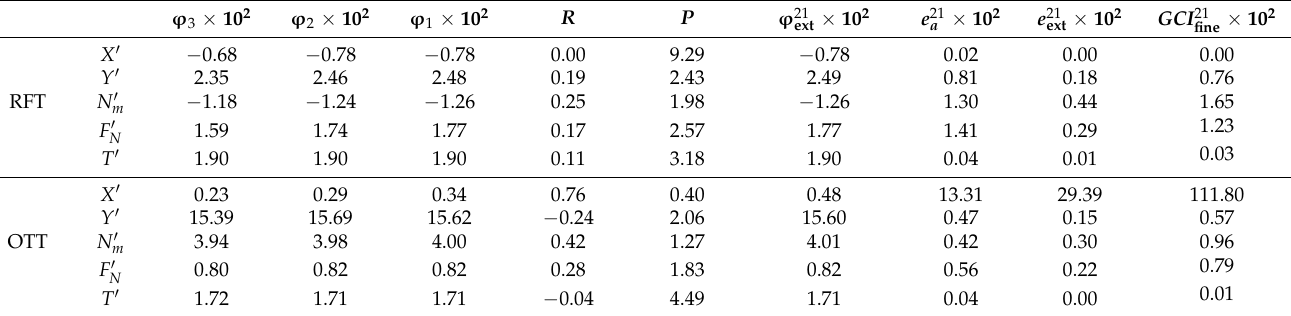
Table 5. The discretization error and uncertainty in temporal convergence study (SM